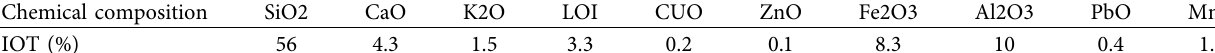
Table 2: Chemical composition of IOT.